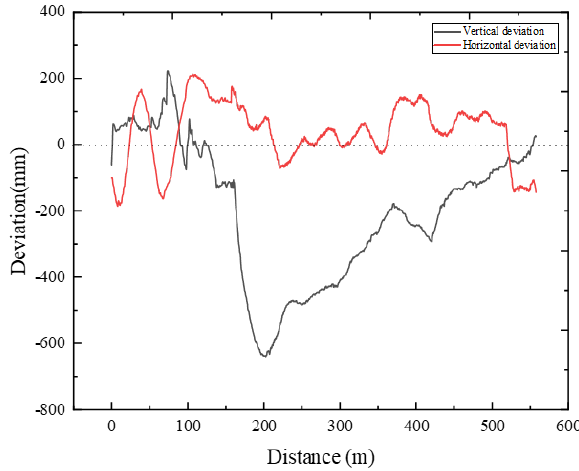
Figure 7. The deviation of the pipeline. 600 400500 Figure 8. The thrust distance over time. 2021 - 7 - 25 2021 - 7 - 27 2021 - 7 - 29 2021 - 7 - 31 2021 - 8 - 2 2021 - 8 - 4 2021 - 8 - 6 2021 - 8 - 8 2021 - 8 - 10 2021 - 8 - 12 2021 - 8 - 14 2021 - 8 - 16 2021 - 8 - 18 2021 - 8 - 20 2021 - 8 - 22 2021 - 8 - 24 2021 - 8 - 26 2021 - 8 - 28 2021 - 8 - 30 2021 - 9 - 1 0100200 300